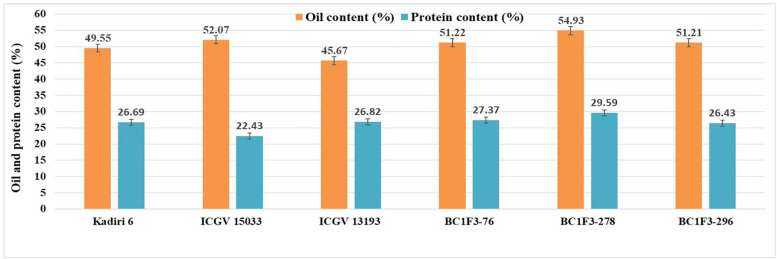
Oil and protein contents of selected Kadiri 6 derived backcrossed lines.